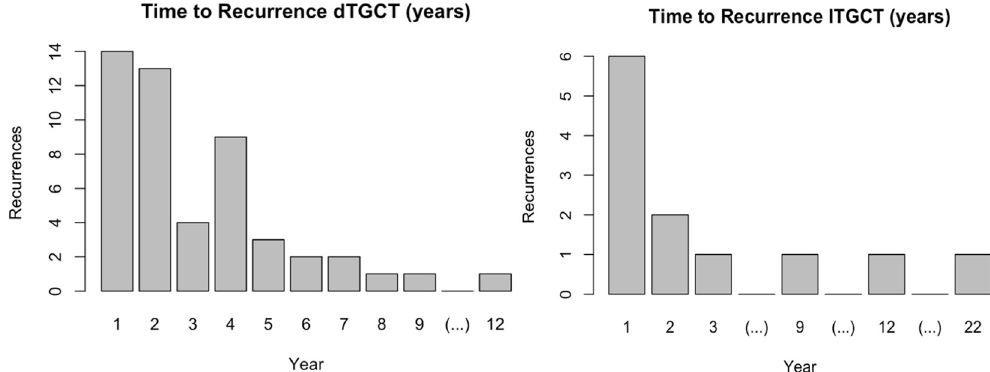
Fig 6. Recurrences (n = 50/63) of diffuse tenosynovial giant cell tumors (dTGCTs), and recurrences (n = 11/13) of localized tenosynovial giant cell tumors (lTGCTs).